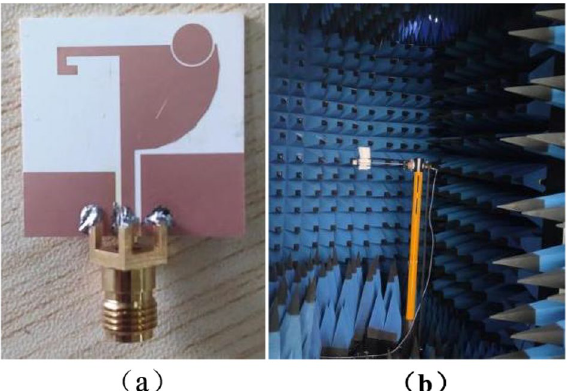
Fig. 9 Fabrication and measurement of the proposed antenna. a The photo of the fabricated CPW antenna. b The testbed of the measured antenna in the